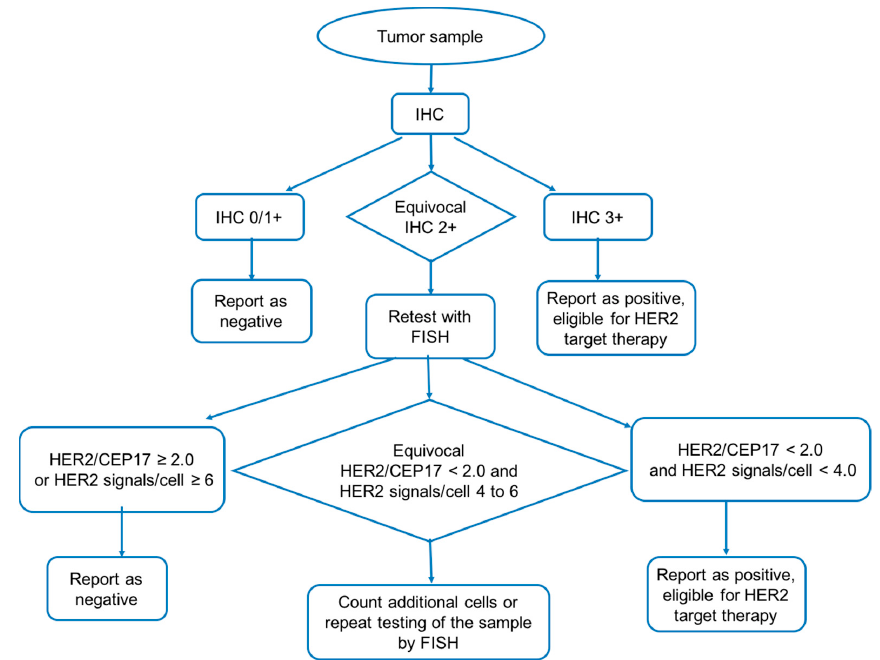
Figure 3. Workflow of HER2 positive breast cancer diagnosis. Tumor samples are initially tested by immunohistochemistry (IHC). Then the samples are divided into three subtypes based on the slide scores of IHC: negative report cases (IHC 0/1+), equivocal cases (IHC 2+) and positive cases (IHC